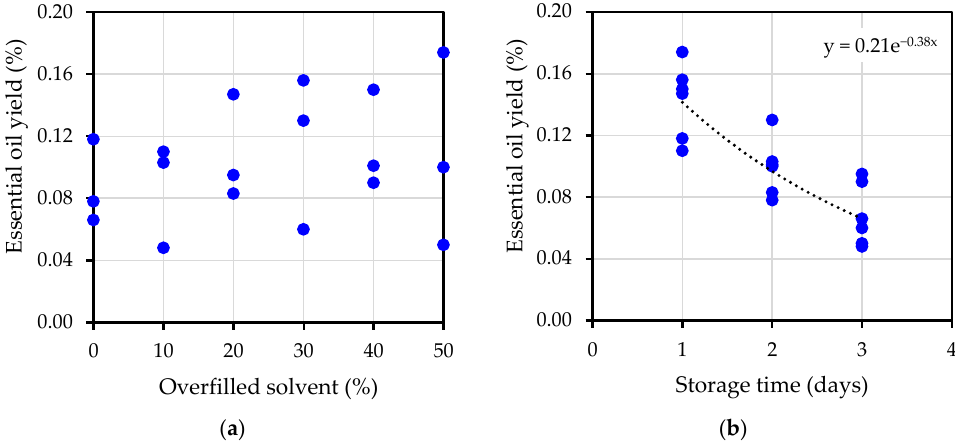
Figure 2. Essential oil yield: ( a ) at varying percentage of overfilled solvent; ( b ) at varying storage time.